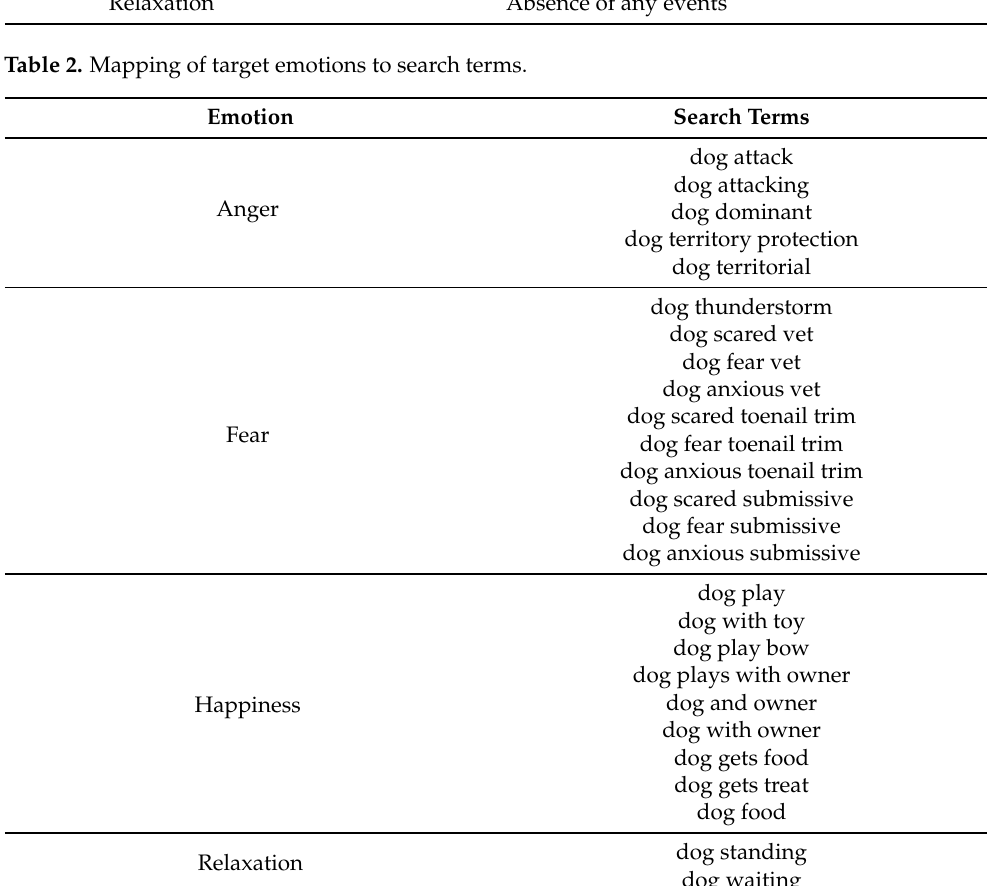
Table 2. Mapping of target emotions to search